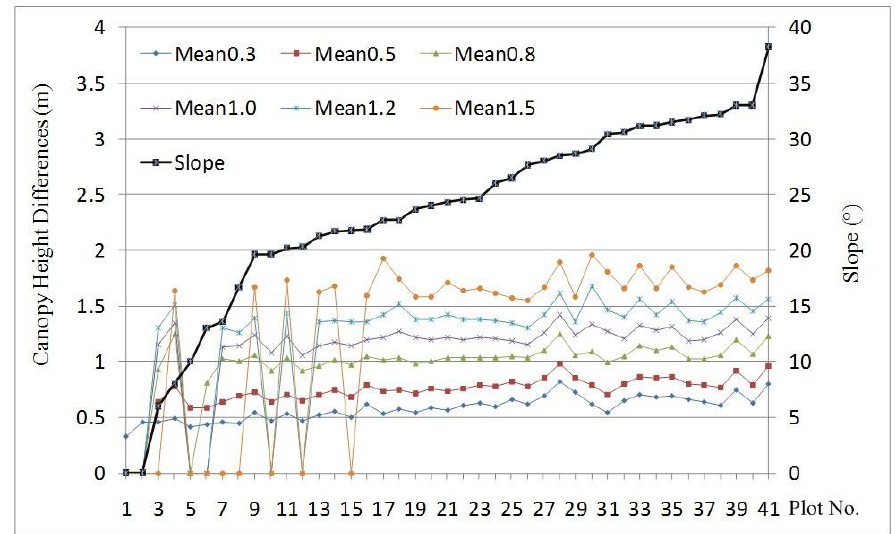
Figure 10. Average values of terrain-triggered canopy height differences versus slope.